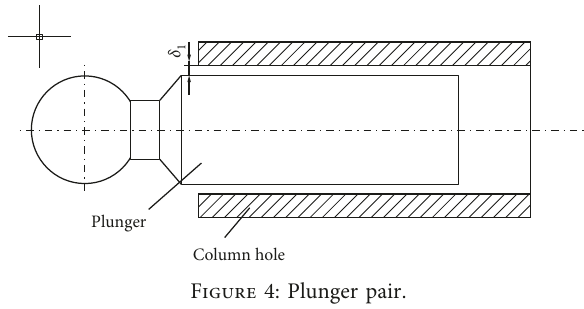
Figure 4: Plunger